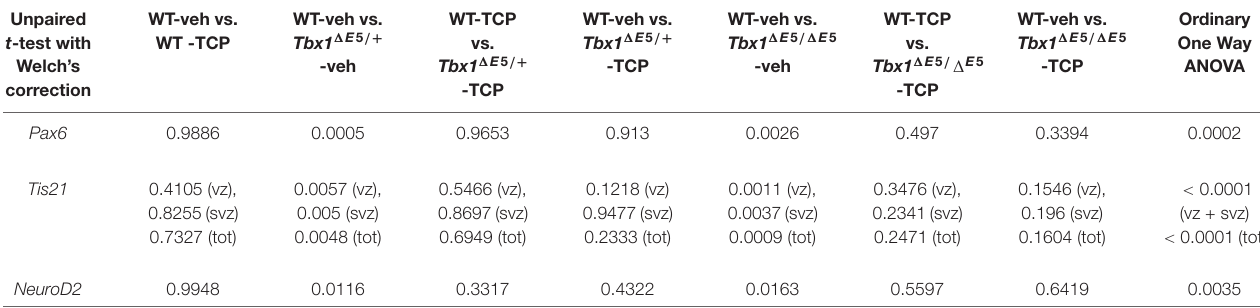
TABLE 1 | P values for the data shown in the graphs (dot-plots) in Figure 1 . Unpaired t -test with